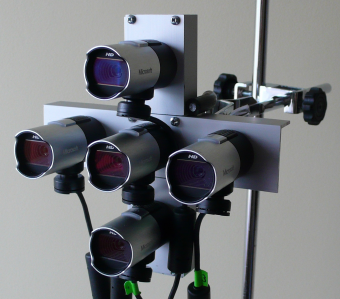
Figure 3. The camera set consisting of MS LifeCam Studio mounted in the form of Equal Baseline Camera